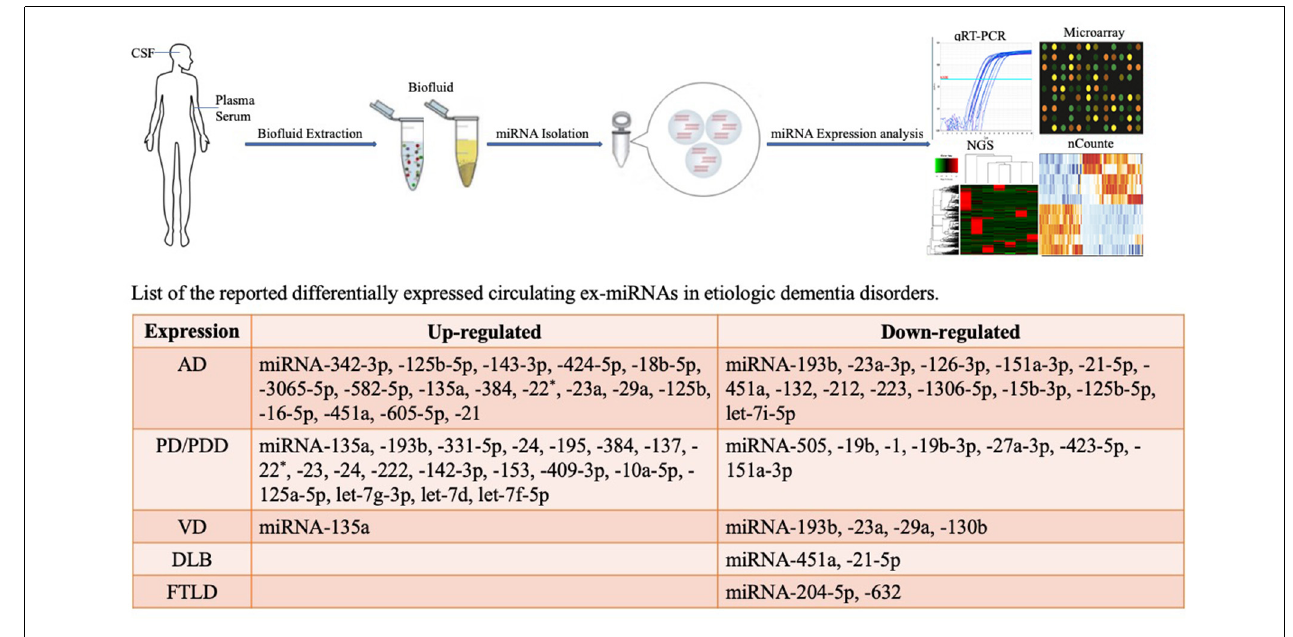
FIGURE 1 | Methodological aspects of circulating biomarker research and circulating exosome miRNAs as biomarkers for dementia disorders.